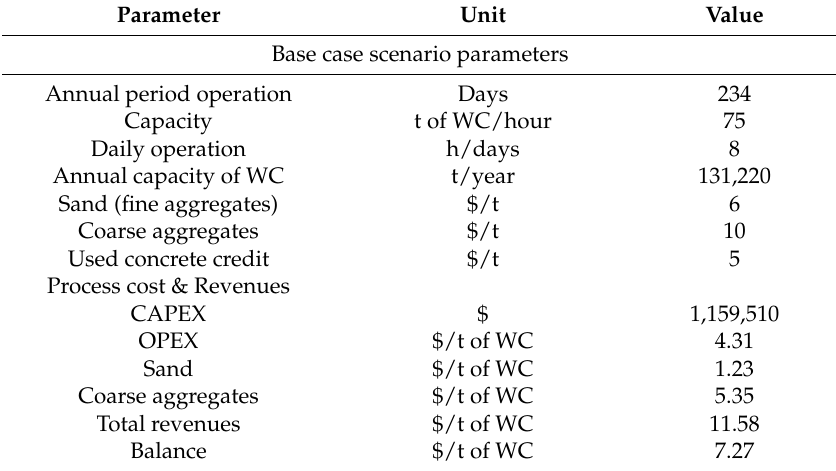
Table 3. Base case scenario parameters and main results for aggregates separation economic